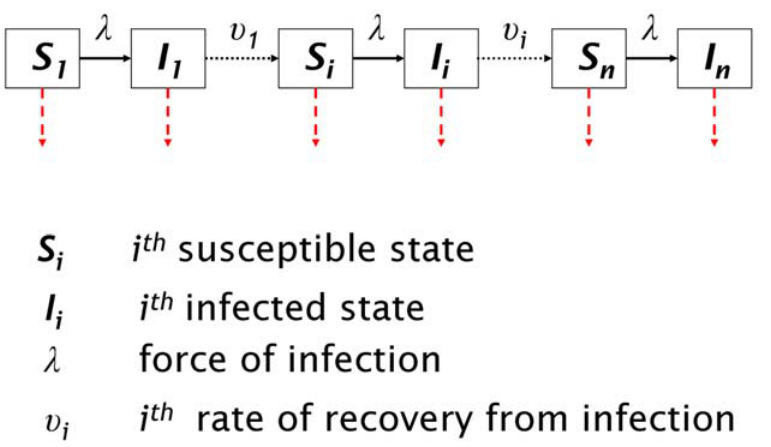
Figure 1. Compartmental diagram of the model. A compartmental diagram illustrating the model described in the text. Each susceptible and infected compartment is connected to the compartment above so that the population passes up a ‘ladder’ of infection. The subscript i corresponds to the number of prior infections experienced.